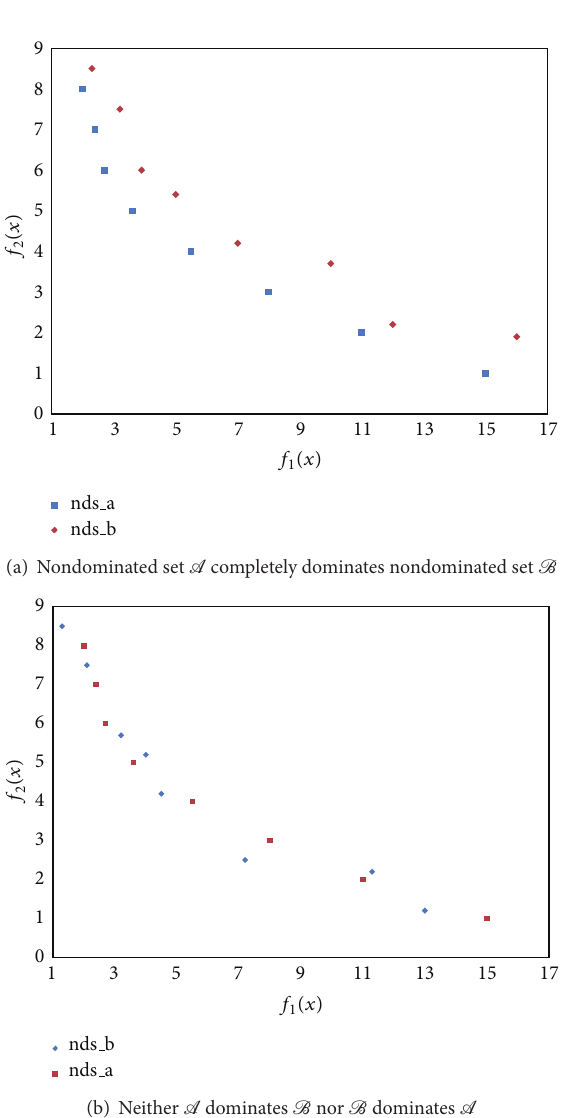
Figure 1: S metric represented as the area that is dominated by a set of (approximately) nondominated